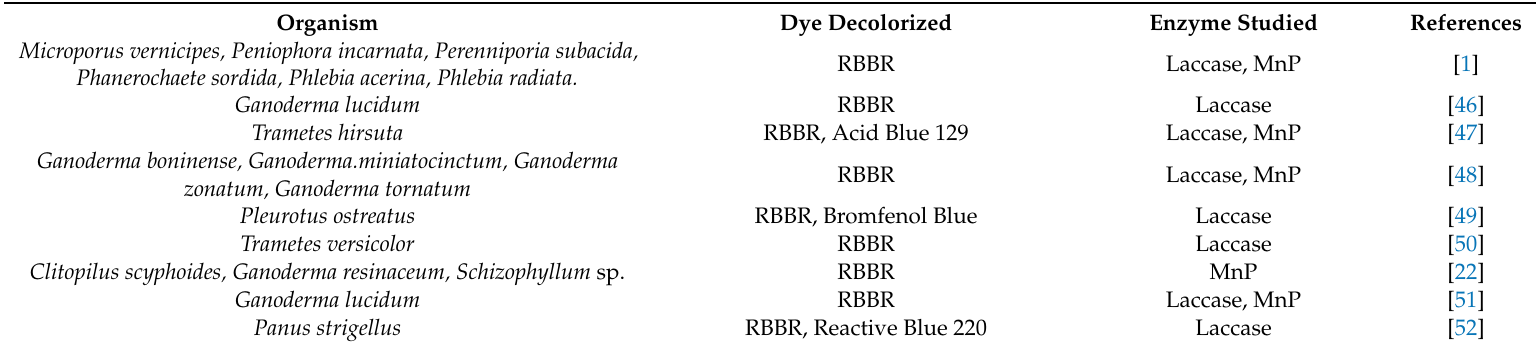
Table 2. Overview of the anthraquinone-dye decolorization capacity and laccase and MnP production in Basidiomycetes. RBBR, Remazol Brilliant Blue R.